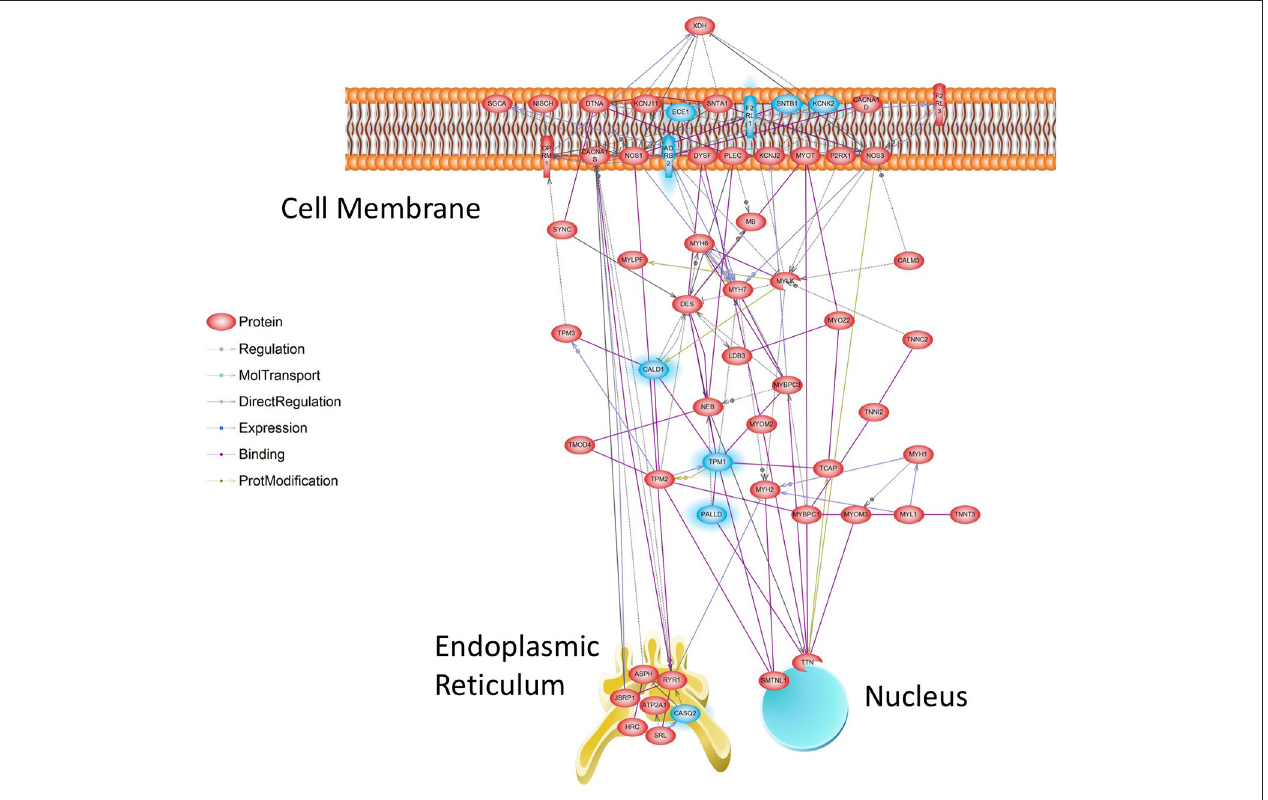
FIGURE 6 | Muscle Contraction Gene Network at 96 h. Transcripts affected by Tr14 treatment were analyzed for their relevance to a series of pre-established biological pathways as described in Methods (Systems Biology). A greater than expected number of transcripts belonged to the Muscle Contraction pathway, which likely reflects wound contraction processes. In this pathway, reconstructed from the literature by Pathway Studio software ( Nikitin et al., 2003), individual transcripts described by their standard gene symbol are connected by lines. Lines may connect genes if one gene product is known to induce the expression of another, if products interact directly, or if one product is a substrate for the other. Transcripts that are increased by Tr14 are highlighted in RED, while transcripts that decreased are shown in